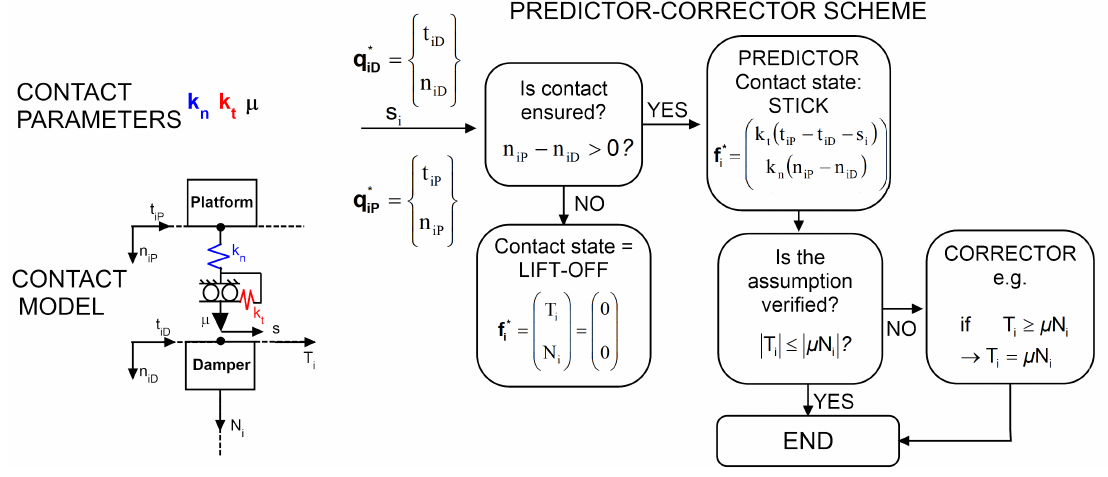
Figure 3. ( Left ) Contact model representation and list of its calibration parameters. ( Right ) Standard implementation of the contact model routine through a predictor-corrector